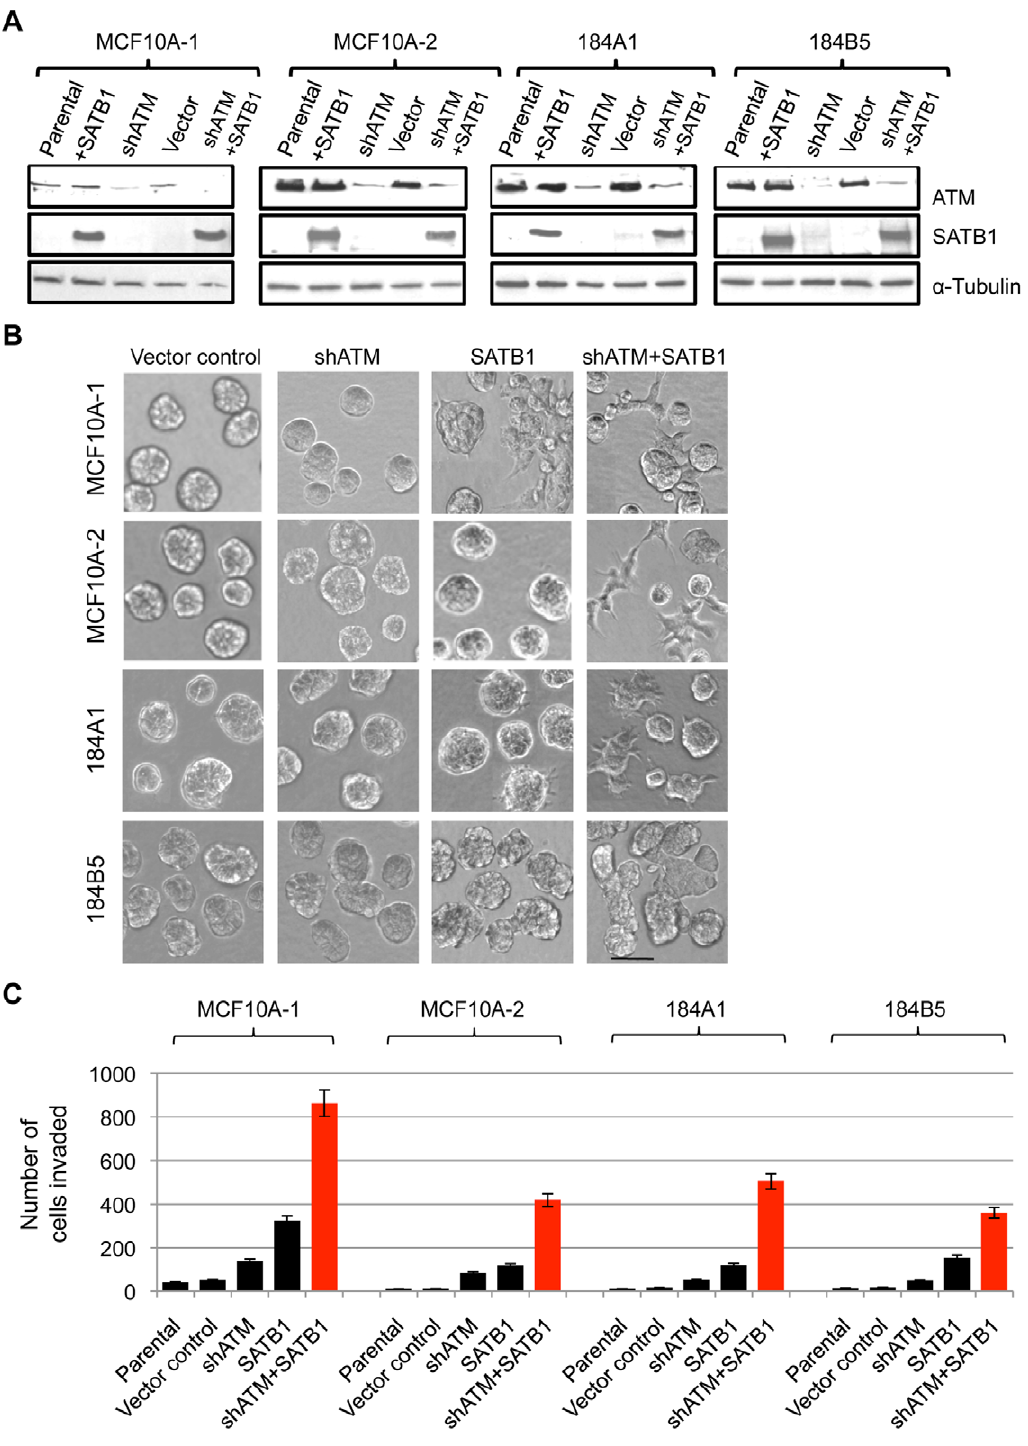
Figure 5. The combination of ectopic SATB1 expression and ATM depletion induces aggressive phenotype in non-malignant mammary epithelial cells. A ) Immunoblot showing ATM and SATB1 levels before and after SATB1 overexpression (SATB1) and ATM depletion (shATM) in non-malignant MCF10A-1, MCF10A-2, 184A1 and 184B5 cells. a -tubulin was used as an internal loading control. B ) Colony morphologies of vector control, ATM depleted (shATM), SATB1 overexpressing (SATB1) and ATM depleted/SATB1 overexpressing (shATM + SATB1) cells generated as in ( C ). Cells were grown in 3D Matrix on-top cultures. The images were captured with phase 1 at 20X magnification on five days after plating. Scale bars, 100 m m. D ) Invasion assay of ATM depleted (shATM), SATB1 overexpressing (SATB1) and ATM depleted/SATB1 overexpressing (shATM + SATB1) cells generated as in ( a ). Error bars indicate 6 s.e.m., n=3 experiments.